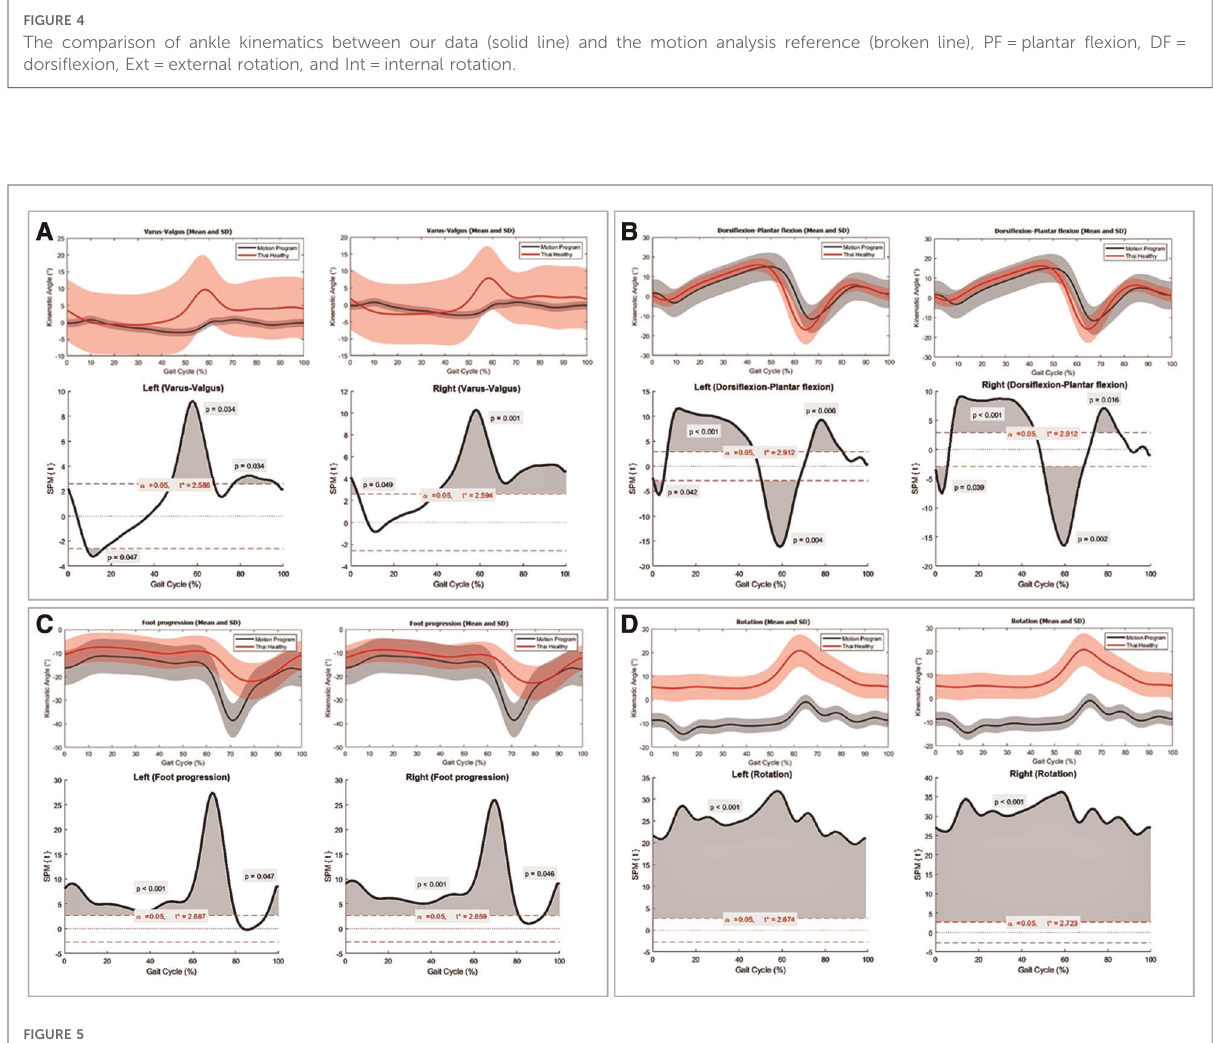
FIGURE 5 The comparisons of right and left ankle kinematics between Thai adults (red), the reference values of the motion analysis program (grey), mean (line) and standard deviation (shaded area). Statistical parametric mapping (SPM) demonstrated full-time series analysis of different ankle kinematics between two data sets (black curve). Grey areas under the black curve represented signi fi cant differences at gait cycle (%) point of time with P <0.05. ( A ) varus-valgus, ( B ) dorsi fl exion-plantar fl exion, ( C ) foot progression, and ( D ) ankle rotation